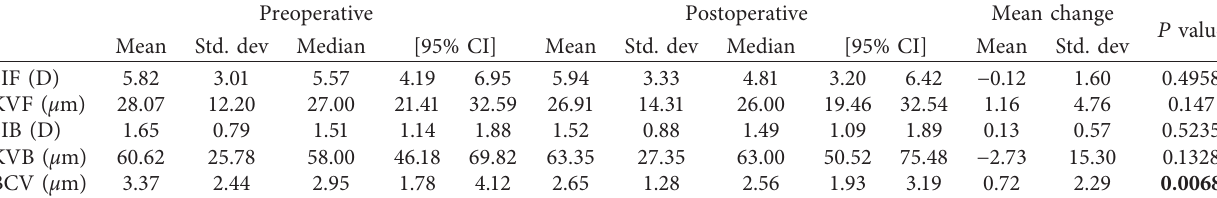
Table 4: Changes in keratoconus screening indices after accelerated cross-linking in pediatric